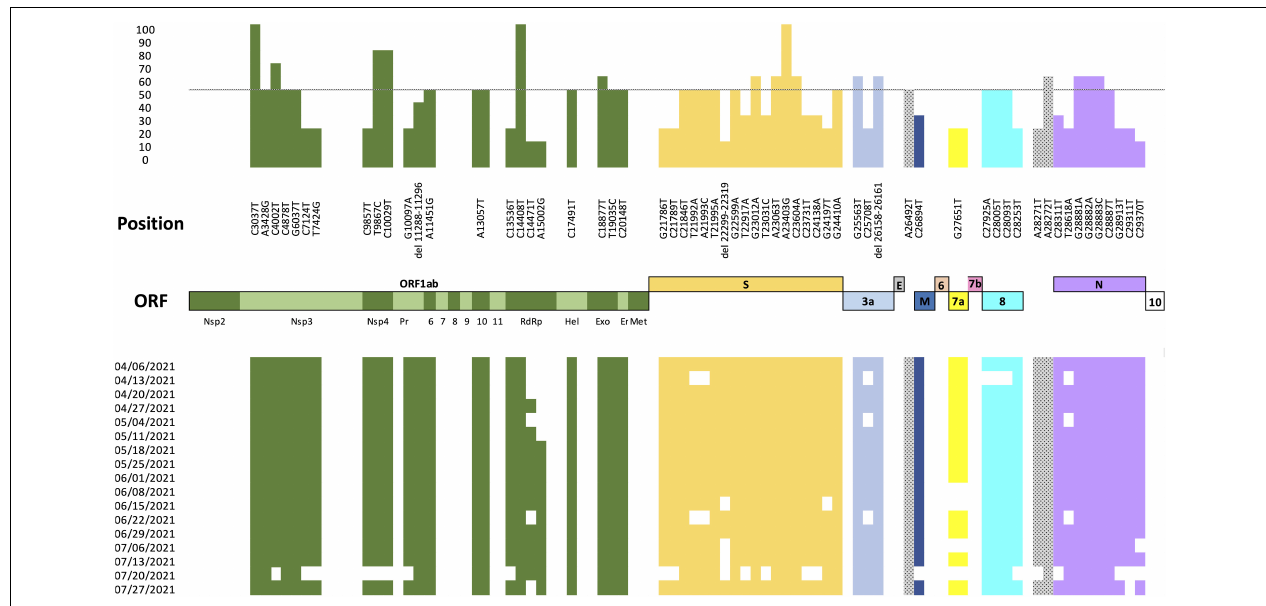
FIGURE 4 | Nucleotide diversity of the Cali genomes. Analysis of nucleotide diversity by comparing the 228 Cali SARS-CoV-2 genomes and the Wuhan reference sequence (hCoV-19/Wuhan/Hu-1/2019), GenBank accession number: NC_045512.2 over time. The upper panel represents in the X -axis the position of each mutation within the SARS-CoV-2 genome and in the Y -axis the percentage of genomes with the mutation. The lower panel shows the presence (represented with color) or absence (represented without color) of each substitution found in the 228 Cali genomes analyzed between April 4 2021 and July 31